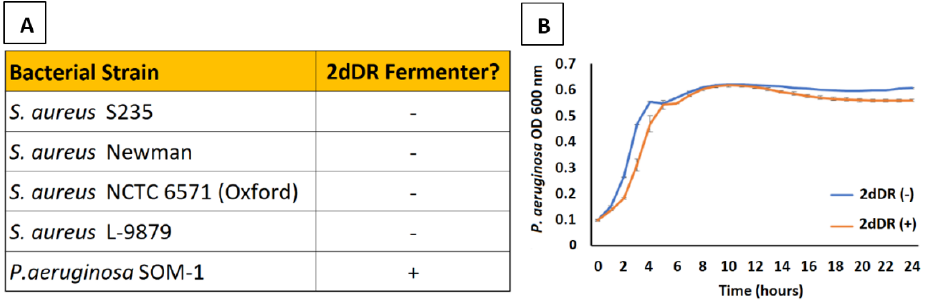
Figure 6. ( A ) Among the four strains of S. aureus tested, none were capable of fermenting 2dDR whilst the P. aeruginosa strain was a fermenter of 2dDR [29]. ( B ) Growth curves measuring optical density (absorbance at 600 nm) of P. aeruginosa SOM-1 over 24 h in media supplemented with and without 2dDR reveal that there is no effect of growth of this strain. Error bars represent the SEM (n = 3).